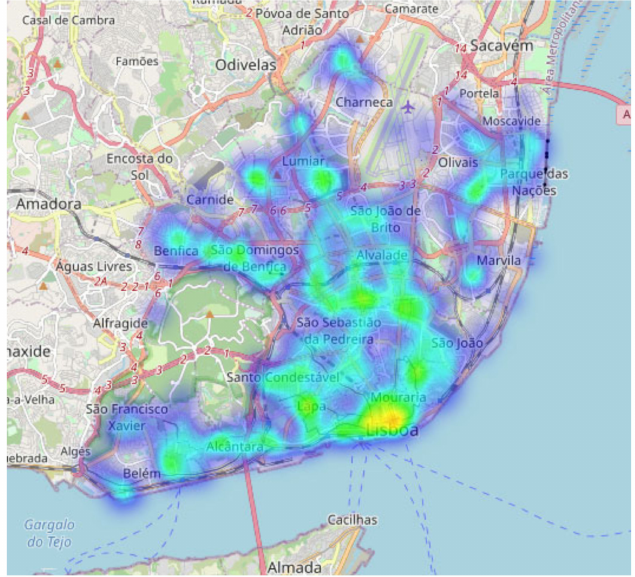
Figure 8. Runover distribution in Lisbon in 2019. Orange and yellow represent streets where more runovers occurred; green and blue represent less common places for runover occurrences.